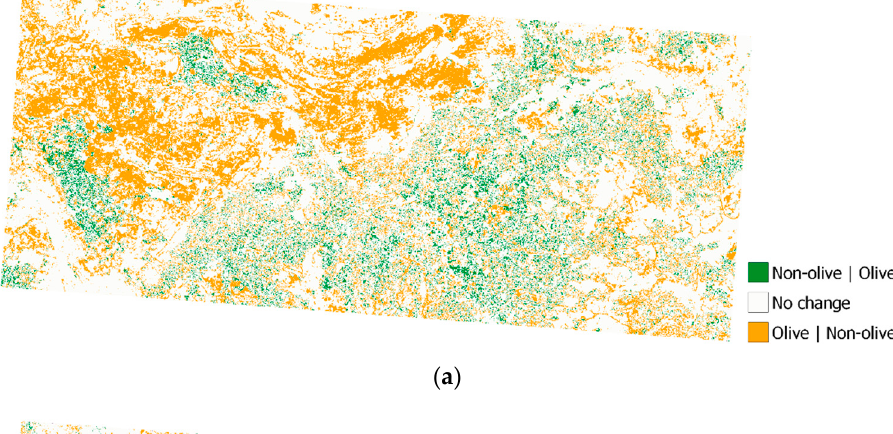
Figure 5. Classification maps from ( a ) the baseline pipeline; ( b ) the multi-classifier pipeline using Multi-Layer Perceptron (MLP); ( c ) the multi-classifier pipeline using One-class Support Vector Ma- chine (OCSVM).